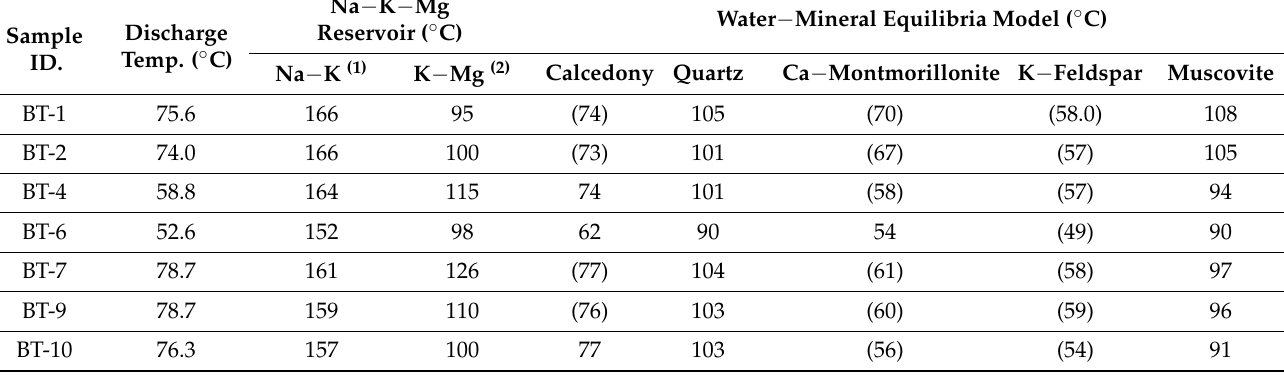
Table 4. Estimated reservoir temperature of Bugok thermal